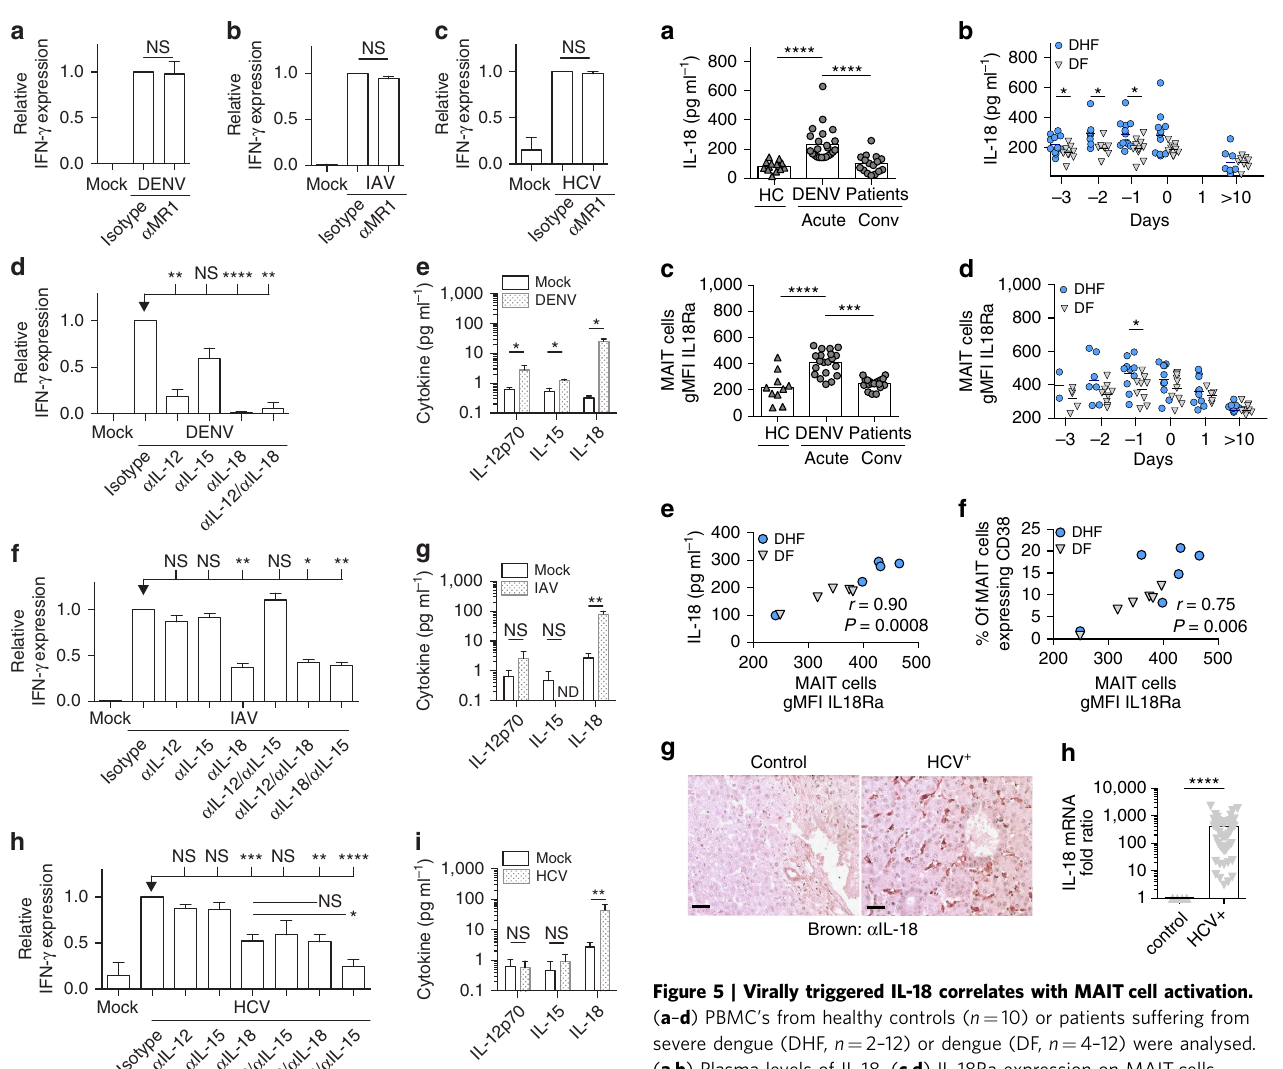
TCR (Supplementary Fig. 8a), CD161 þþ V a 7.2J a 33 þ CD4 T cells (Supplementary Fig. 8b) and CD4 (cid:2) CD8 (cid:2) T cells